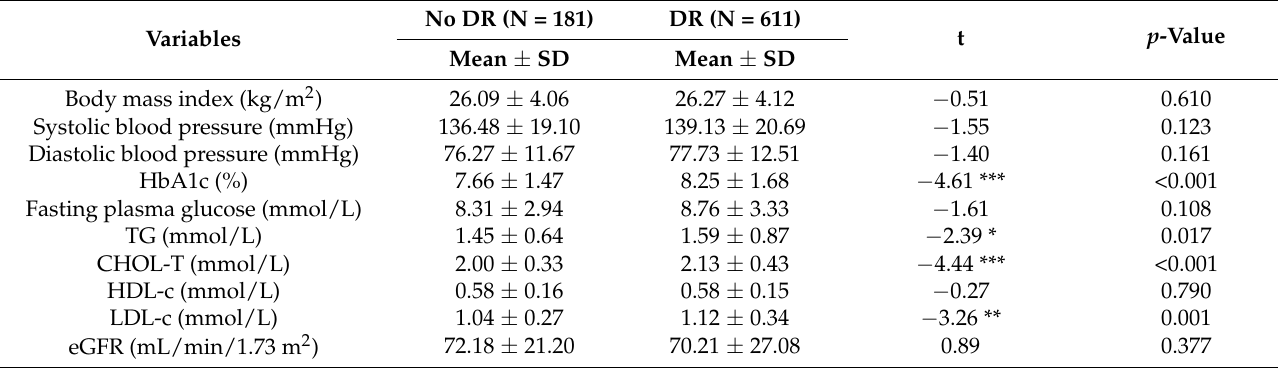
Table 2. Comparison of continuous variables between the patients with and without DR (N = 792).